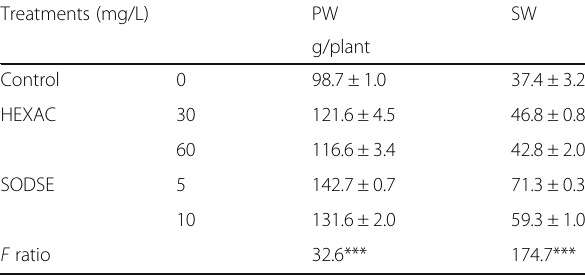
or roots at various GRS compared with control. Table 2 Effect of HEXAC or SODSE on PW and SW Treatments (mg/L) PW SW g/plant